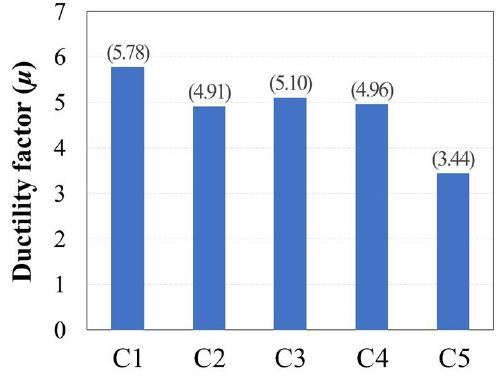
Figure 10. Comparison of ductility factors ( μ ).